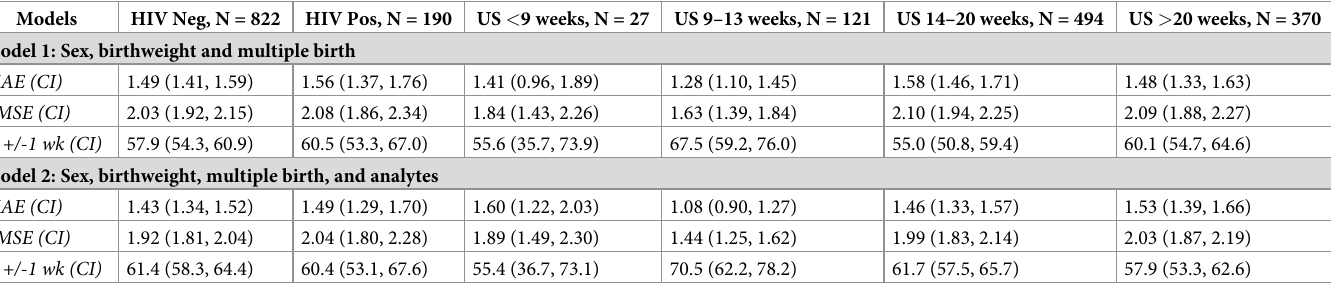
MAE: Mean absolute error; RMSE: Root mean square error; SGA: small for gestational age Data are presented as the mean and 2.5th and 97.5th bootstrap percentiles for MAE, RMSE and the percentage of model estimates within 1 and 2 weeks of ultrasound GA for 1000 bootstrap samples generated from each